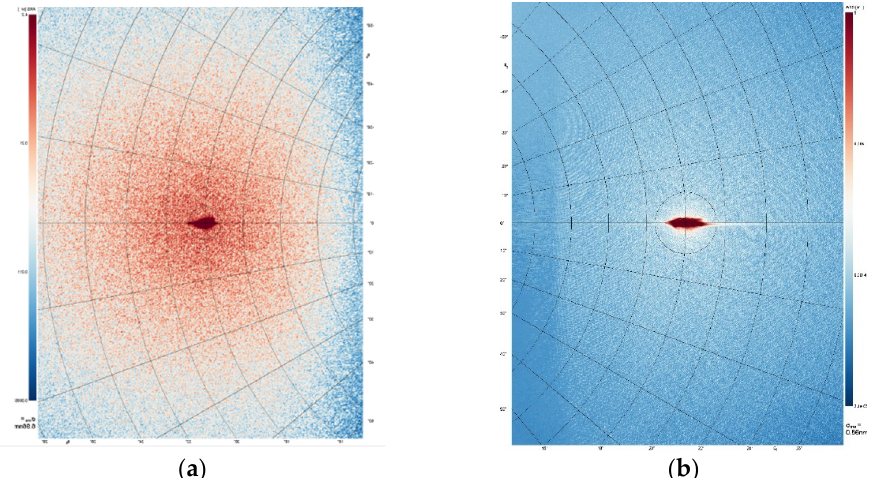
Figure 11. The scattering image of small particles on the superpolished sample ( a ) and the instrument signature ( b ).